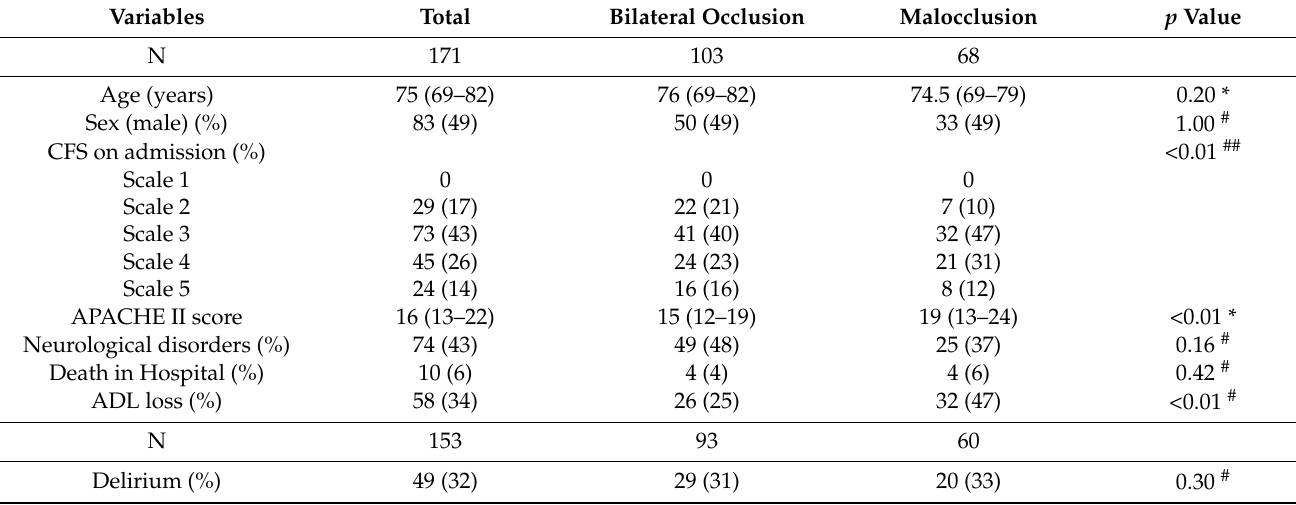
Table 2. Baseline characteristics of the study population 65 years and older.